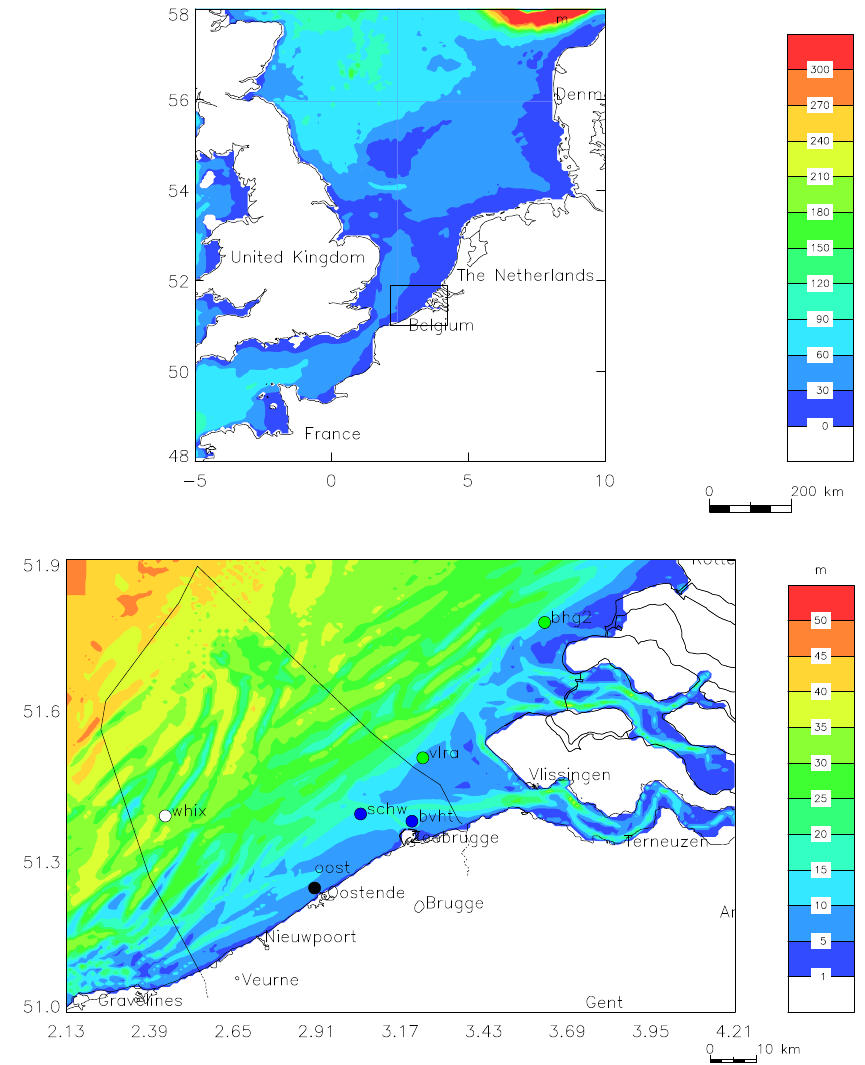
Figure 1: Above: Bathymetry of the southern North Sea with the indication of the Belgian Part of the North Sea (BPNS); Below: Bathymetry of the BPNS with the position of the stations where time series were analysed. Following abbreviations are used: whix: Westhinder; oost: Oostende; schw: Scheur West; bvht: Bol van Heist; vlra: Vlakte van de Raan; bhg2: Brouwershavensegat 2. The colours indicate which data were analysed: black: water elevation; white: wind speed; purple: significant wave height; green: wind speed and significant wave